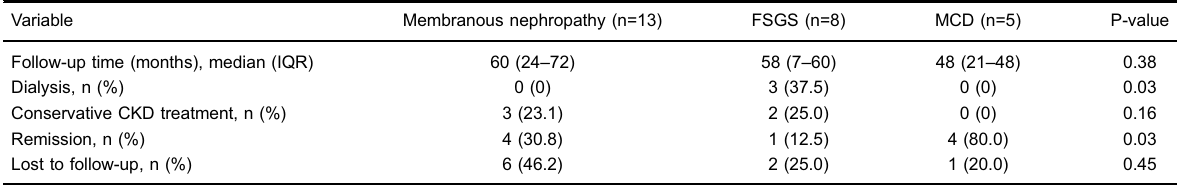
Table 3. Follow-up and outcomes in patients over 65 years of age with nephrotic syndrome by etiology.